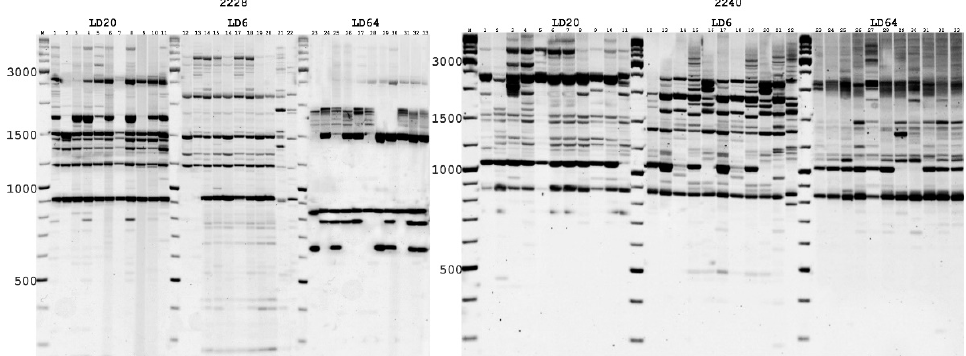
Figure 4. Electrophoretic pattern of A. ledebourianum fragments using PBS primer 2228 and 2240. 1. M—Thermo Scientific GeneRuler DNA Ladder Mix (100–10,000 bp). Samples of LD20 (1–10),